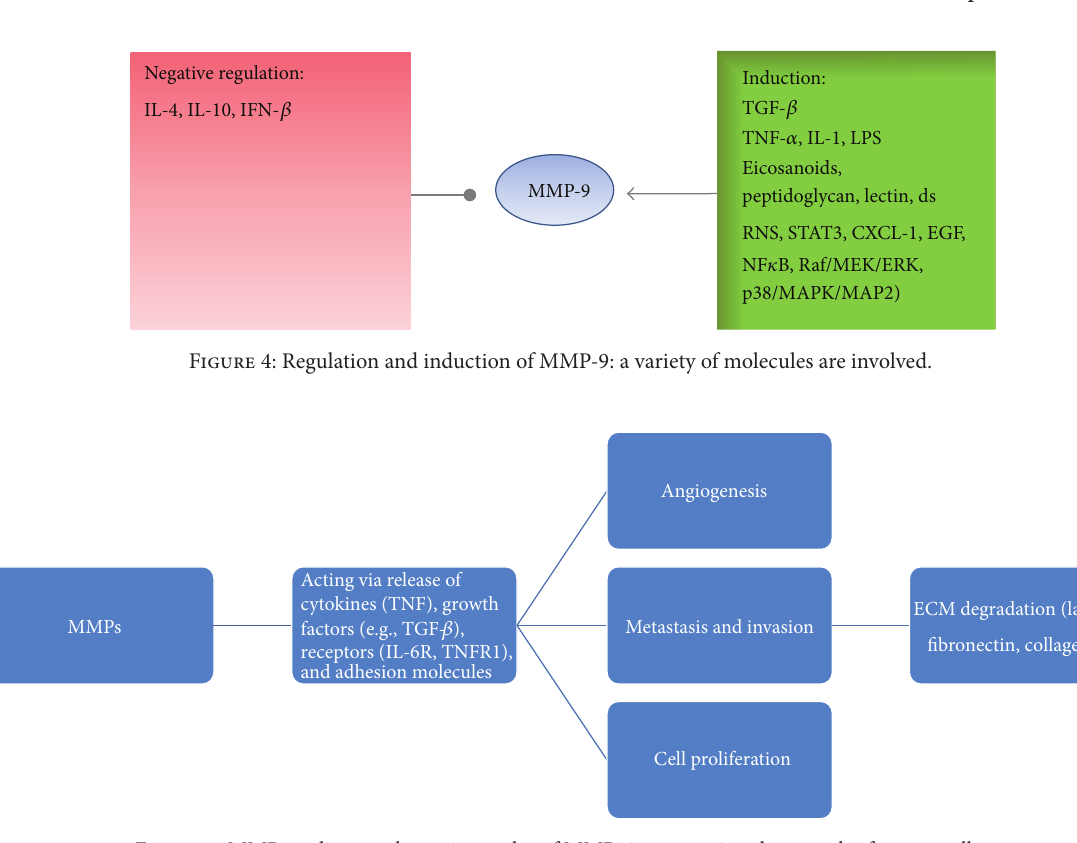
Figure 5: MMP in gliomas: the various roles of MMPs in promoting the growth of cancer